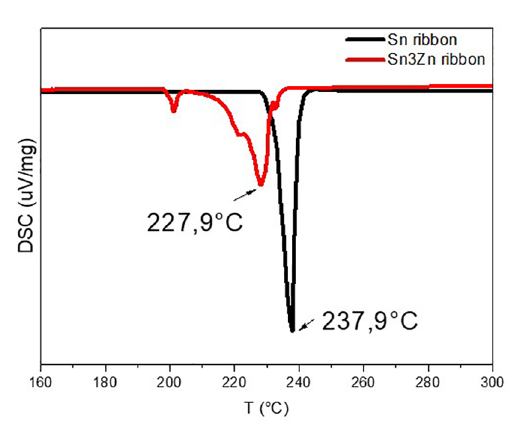
Figure 4. Differential Scanning Calorimetry curves of (black) Sn-ribbons and (red) Sn3Zn ribbons. Table 2. Microhardness (HV) measurements of Sn and Sn3Zn- ribbons.